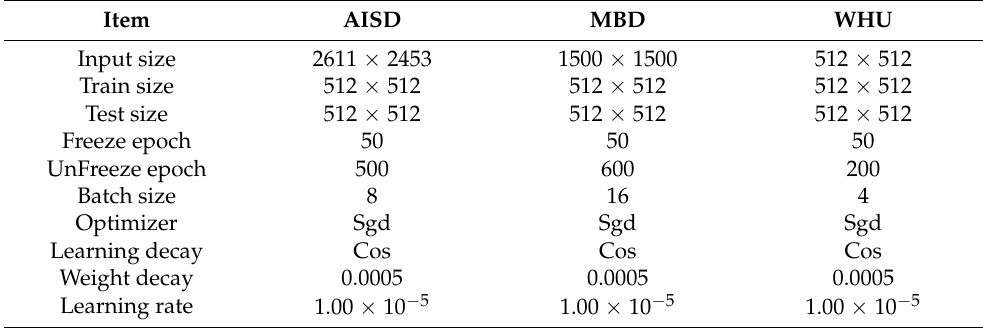
Table 2. Training configuration of the